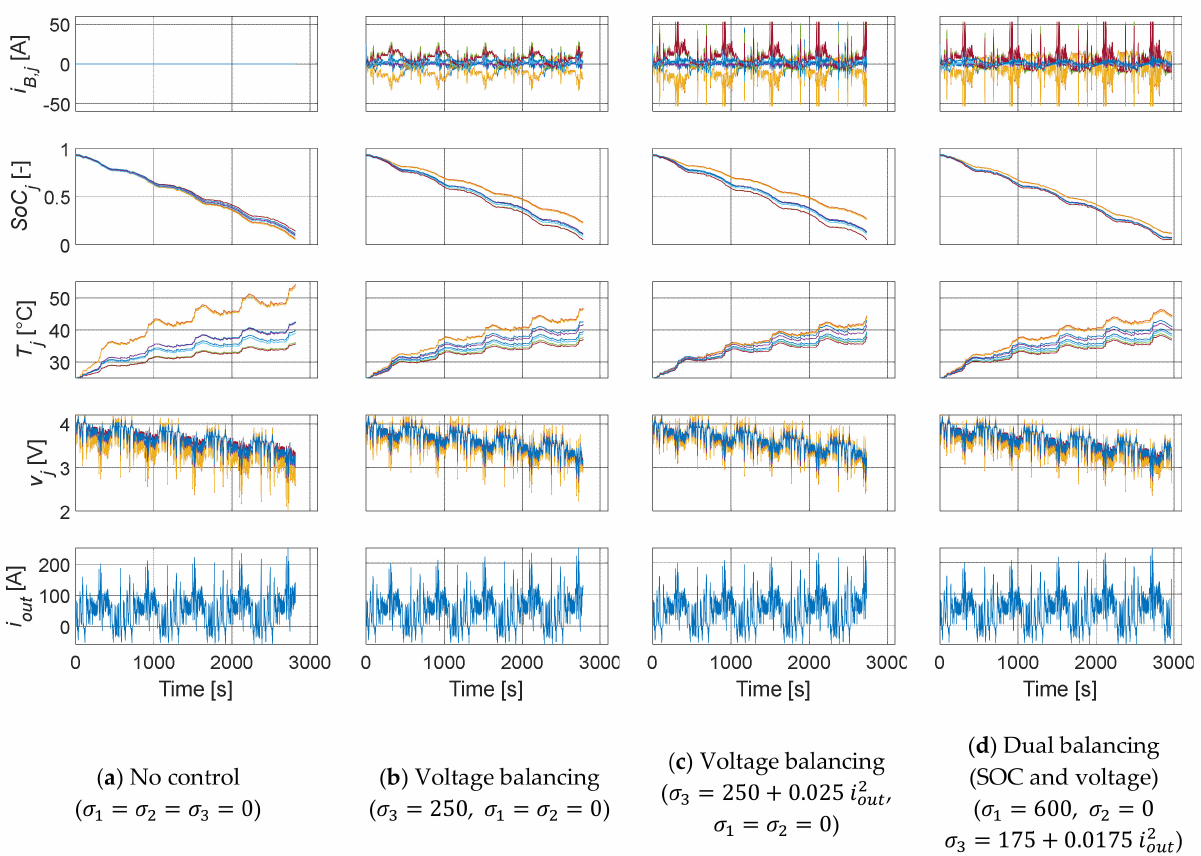
(cid:16) (cid:17) ≤ 0.5. Scenario: aggressive driving SOC j